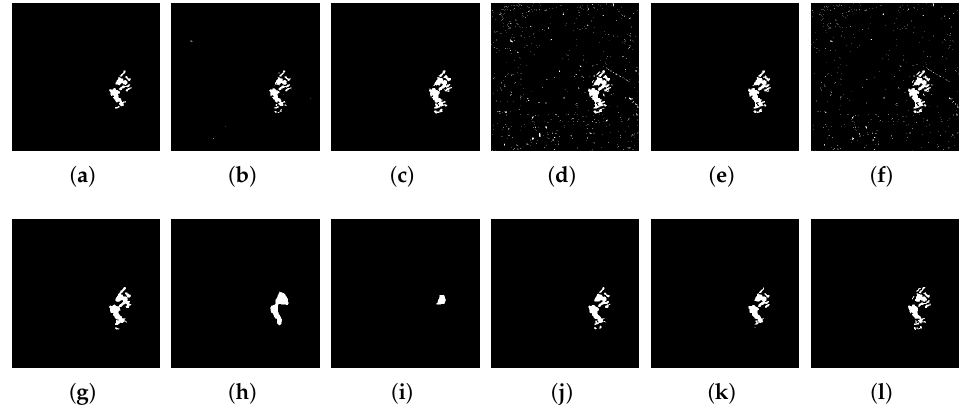
Figure 13. The results of Experiment 1 using Bern dataset. ( a ) DDNet. ( b ) DDNet(WP). ( c ) HFEMCRF. ( d ) HFEMCRF(WP). ( e ) FCMMRF. ( f ) FCMMRF(WP). ( g ) SAFNet. ( h ) HFEM-PSPNet. ( i ) HFEM-